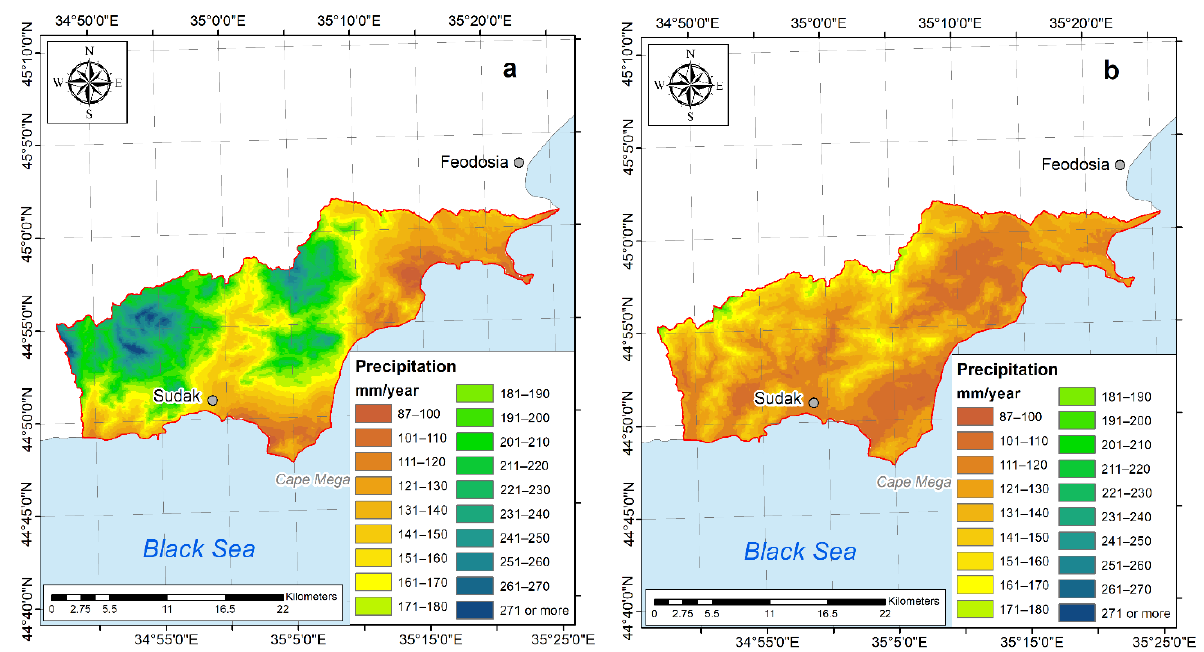
Figure 2. Average precipitation on the territory of Southeastern Crimea for the winter ( a ) and summer ( b ) periods.